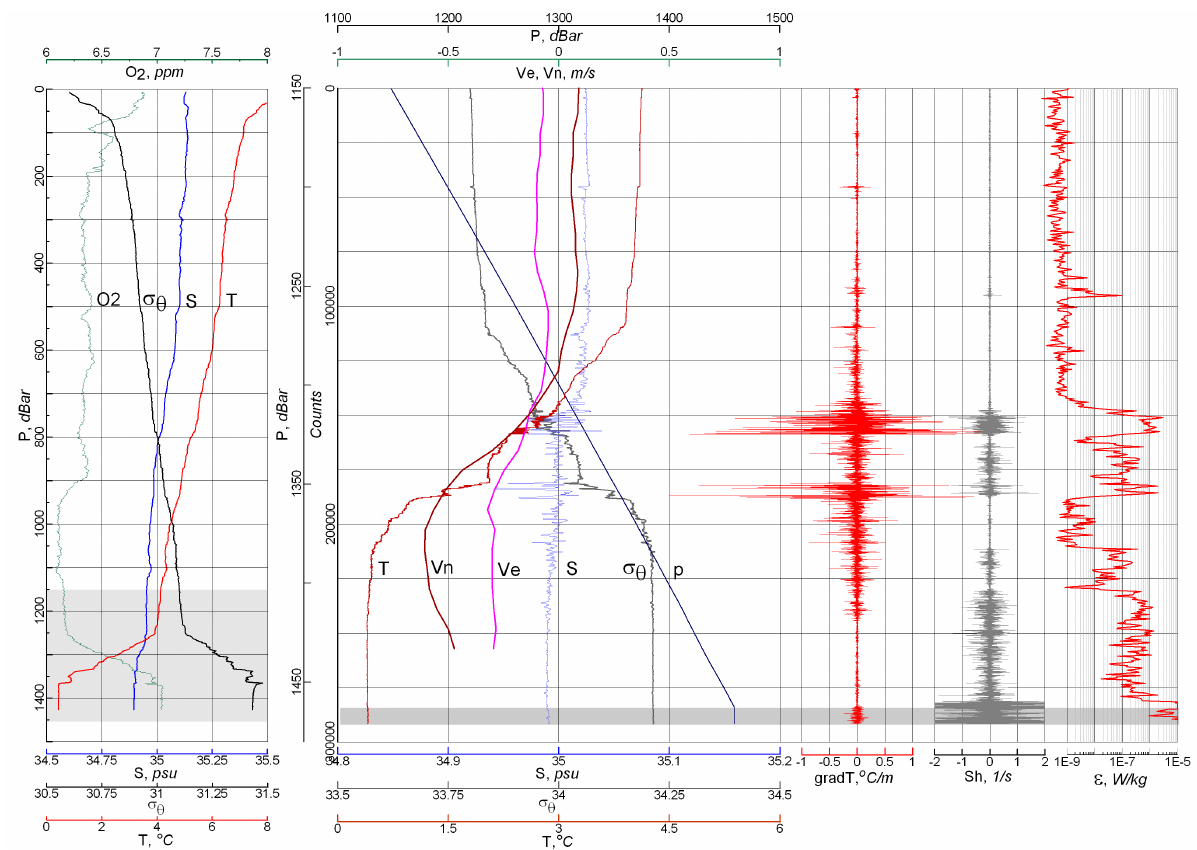
Fig. 4. An example of the MSP/CTDO/LADCP data obtained at station 119 (see text for details).